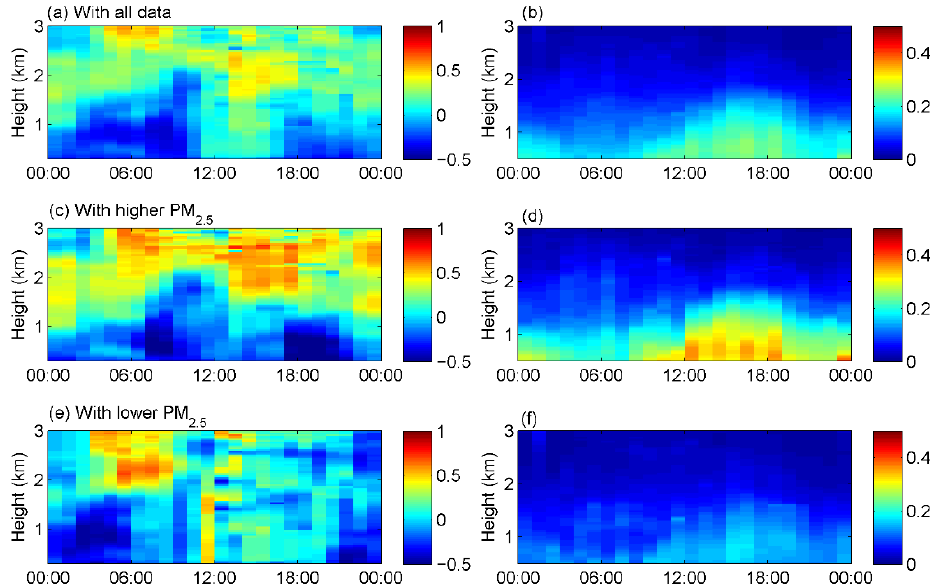
Figure 9. Diurnal variations in the correlation coefficient between aerosol extinction coefficient and ozone concentration at different heights ( a , c , e ) and diurnal variation in aerosol extinction coefficient ( b , d , f ). The correlation coefficient and aerosol extinction coefficient are calculated from data of all observation days ( a , b ), the days with average PM 2.5 > 35 µg m − 3 ( c , d ), and the days with average PM 2.5 < 35 µg m − 3 ( e , f ), respectively.